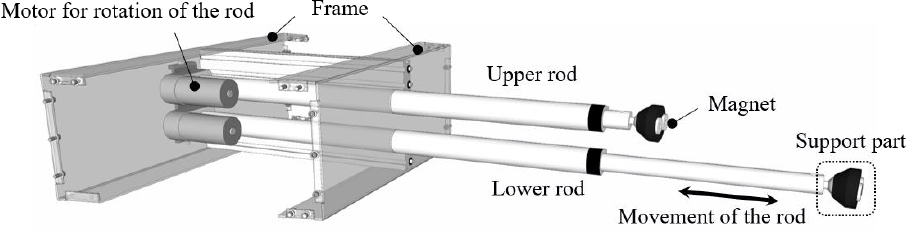
Figure 12. Configuration of the rod.